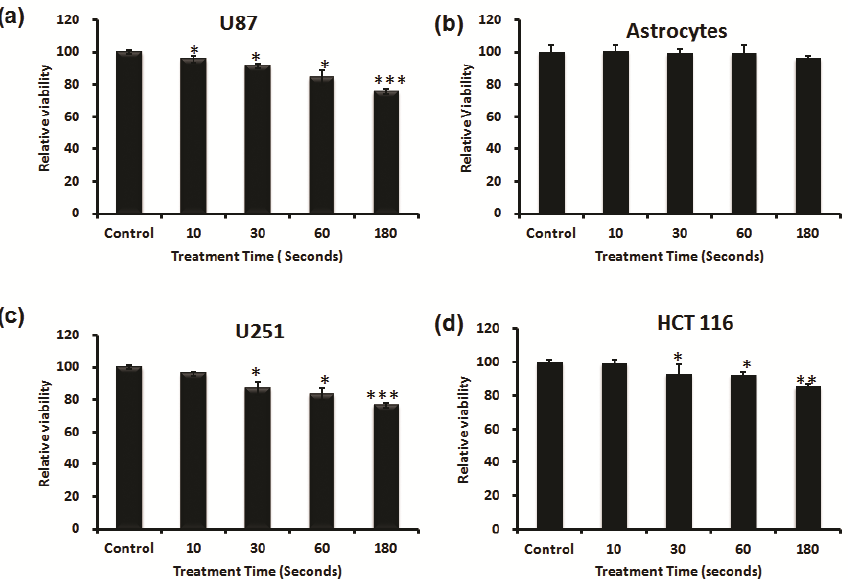
Figure 2. Effects of NBP-J on cell viability of ( a ) U87 MG, ( b ) astrocytes, ( c ) U251, and ( d ) HCT116 cell lines for different treatment durations from 10 to 180 s. An Alamar blue assay was performed after 24 h of treatment. Data are presented as means ± SD of three independent sets of experiments. * p < 0.05, ** p < 0.01, and *** p <